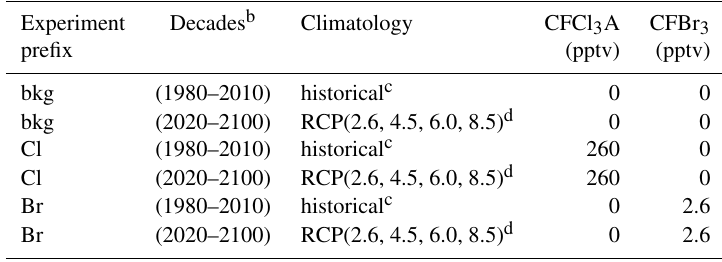
Table 1. Experiment schedule a